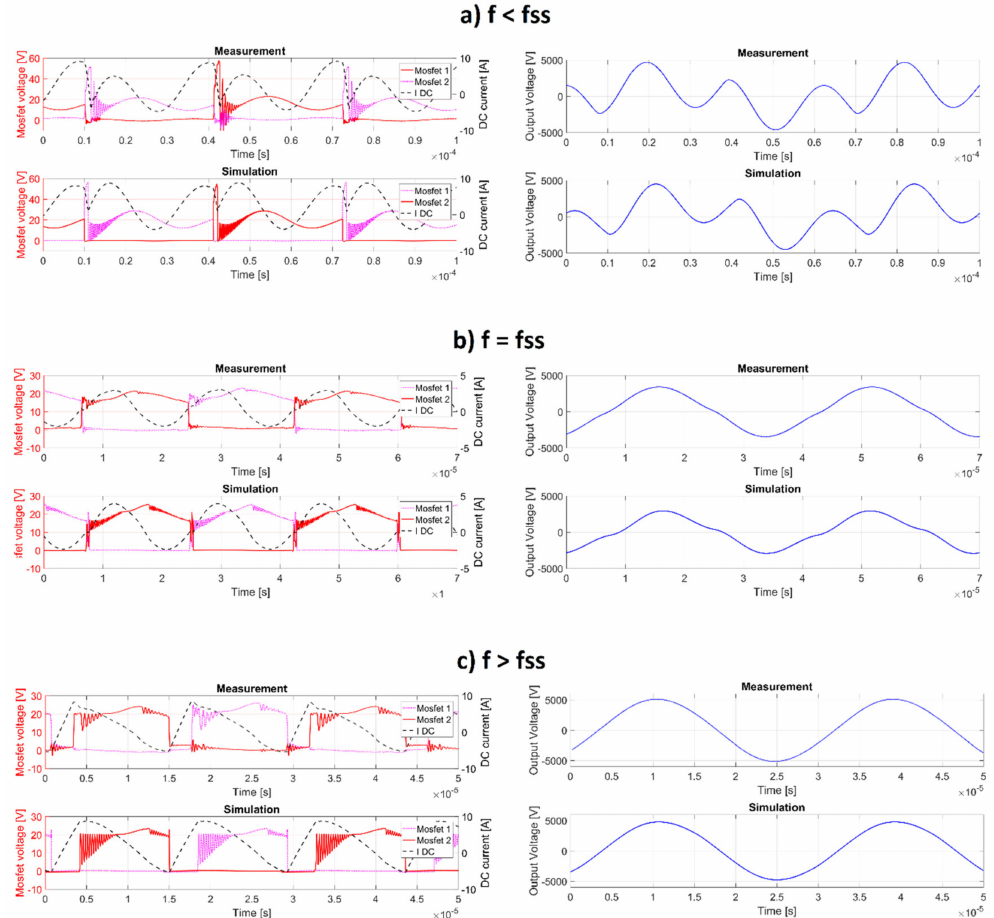
Figure 9. Comparison between measured and calculated MOSFET voltages, bus DC current (left-hand side) and output high voltage (right-hand side) for a frequency ( a ) less than the soft switching frequency; ( b ) equal to it; and ( c ) greater than